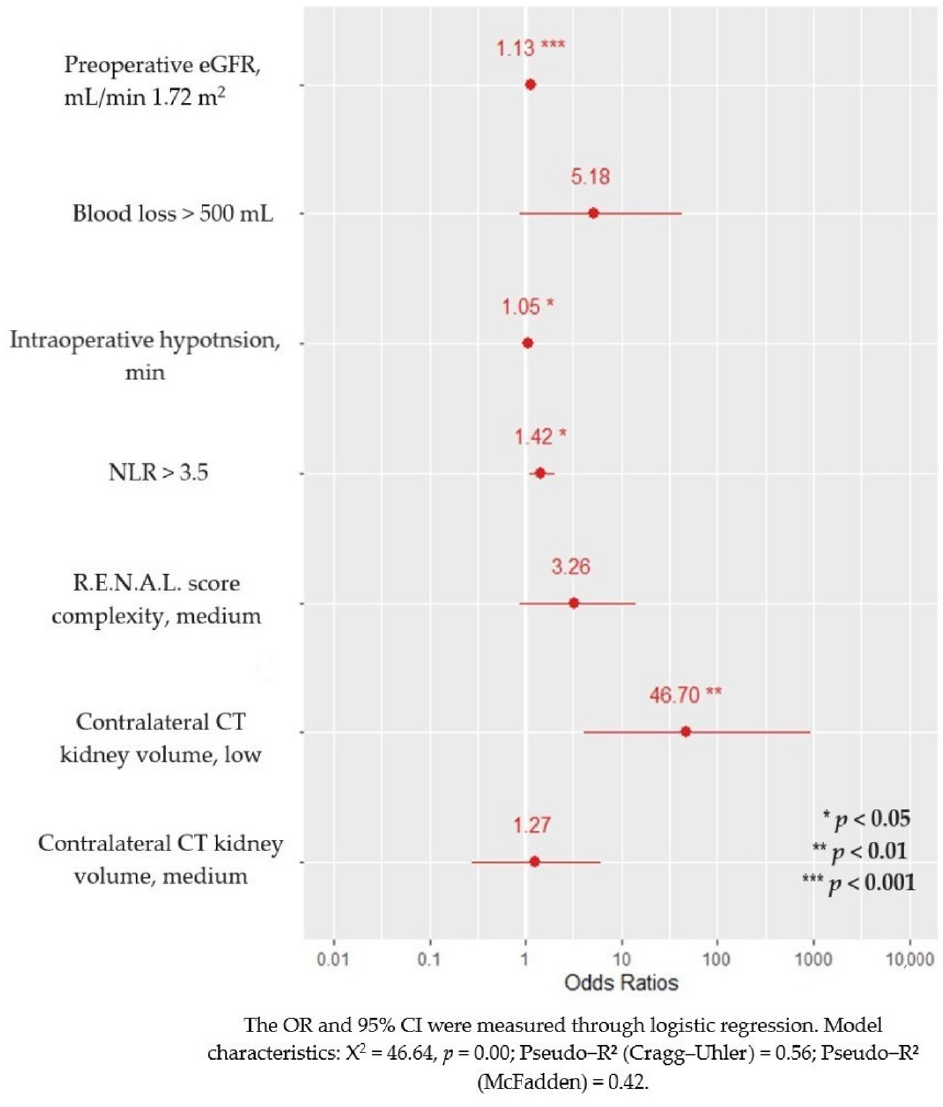
Figure 7. Risk factors of clinically significant AKI after radical nephrectomy. Abbreviations: eGFR— estimated glomerular filtration rate; NLR—neutrophil-to-lymphocyte ratio; CT—computed tomography; R.E.N.A.L.—CT nephrometry scoring system. This logistic regression model’s ROC analysis showed significant sensitivity of 90.1% with specificity of 66.7% as presented in Figure